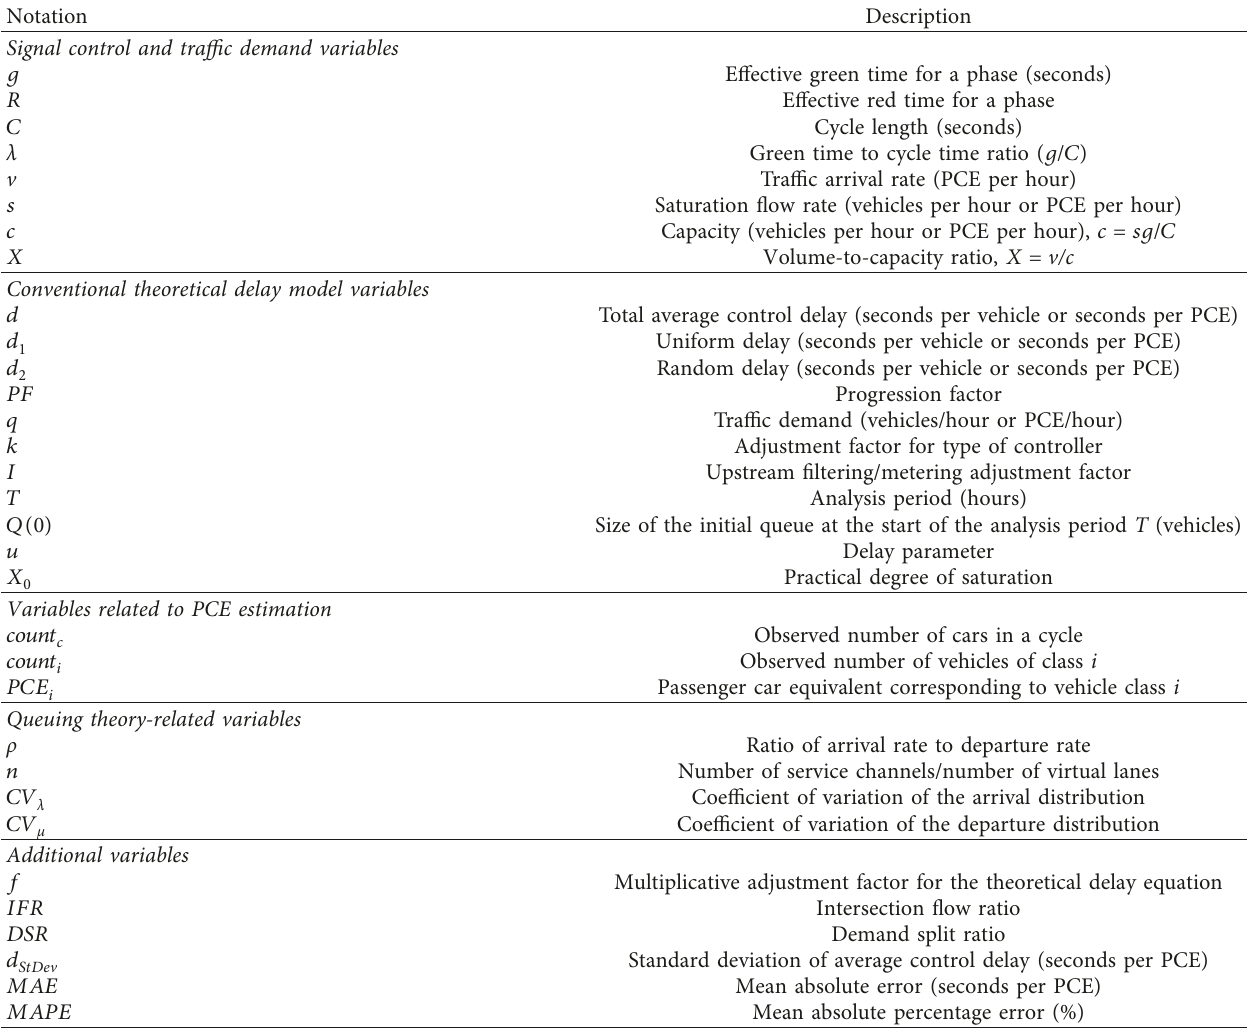
Figure 1. The southbound approach has three lanes.